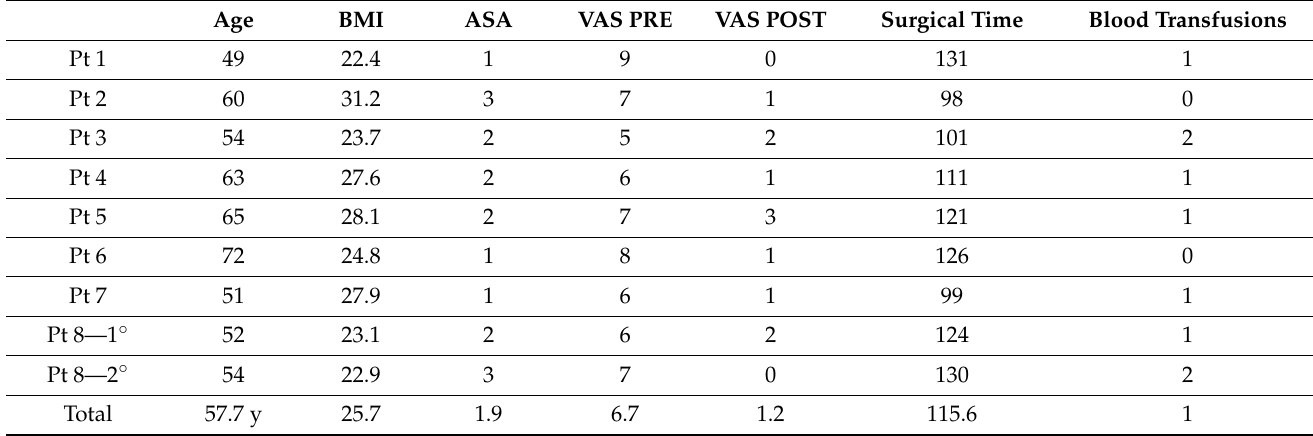
Table 1. Summary demographic and clinical parameters. BMI: Body Mass Index; VAS: Visual analog pain score; ASA: American Society of Anesthesiologists